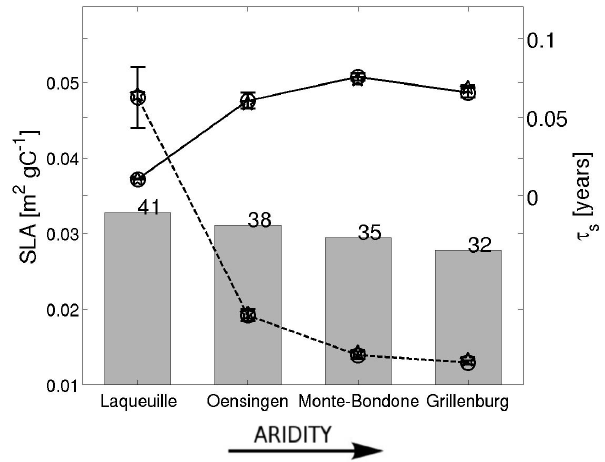
Figure 7. Posterior distributions of the specific leaf area (SLA, dashed line) and characteristic mortality time in stress conditions τ s (plain line) for the four sites (HO2 inversions values), classified as a function of increasing aridity by the De Martonne–Gottman index (grey bars). The mean of the posterior distributions and the most likely parameter values are depicted with a circle and a star, respectively. The error bars stand for one standard deviation around the